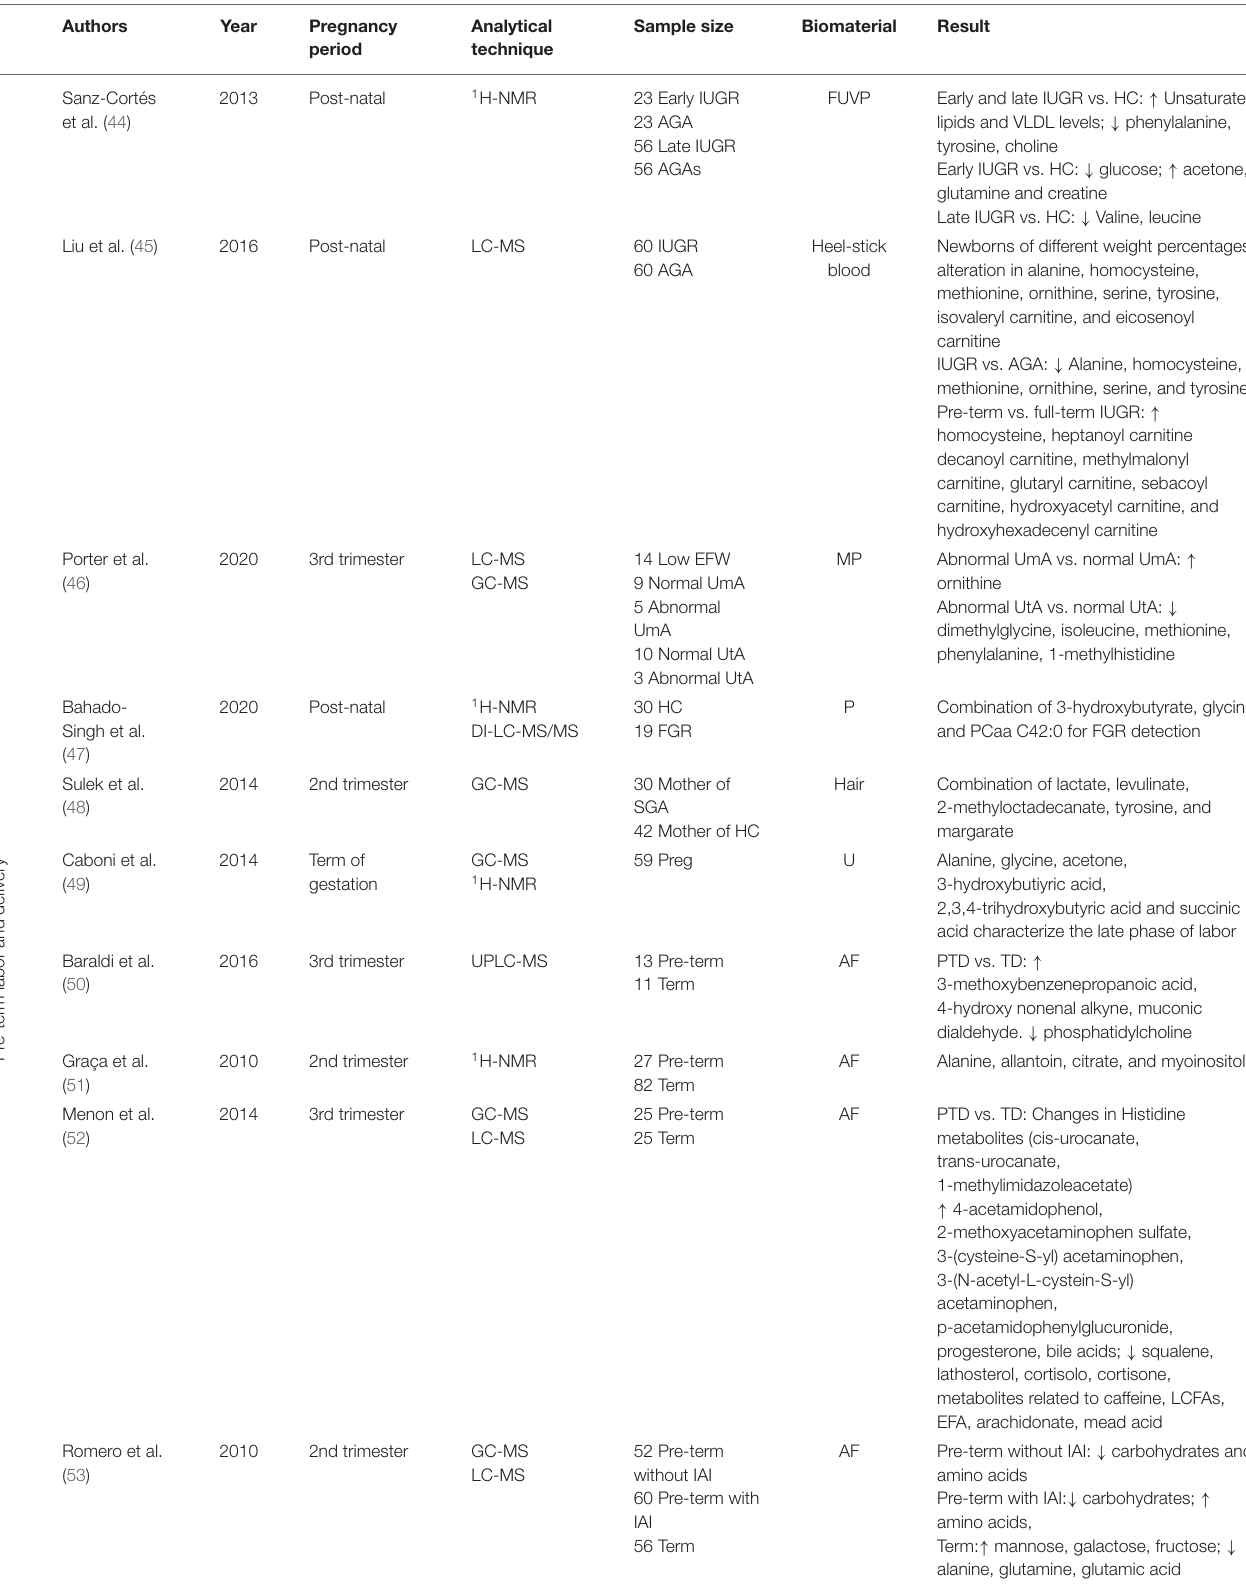
Pre-term without IAI: ↓ carbohydrates and amino acids Pre-term with IAI: ↓ carbohydrates; ↑ amino acids, Term: ↑ mannose, galactose, fructose; ↓ alanine, glutamine, glutamic